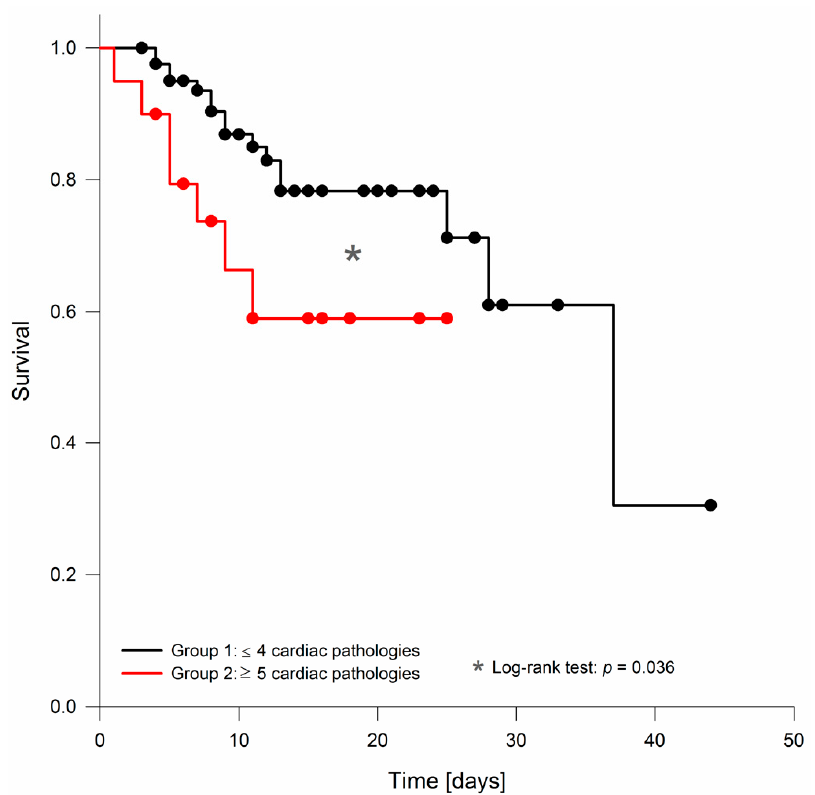
Figure 1. Kaplan–Meier survival curve. Kaplan–Meier survival curves of patients with four or fewer cardiac pathologies and patients with five or more cardiac pathologies.